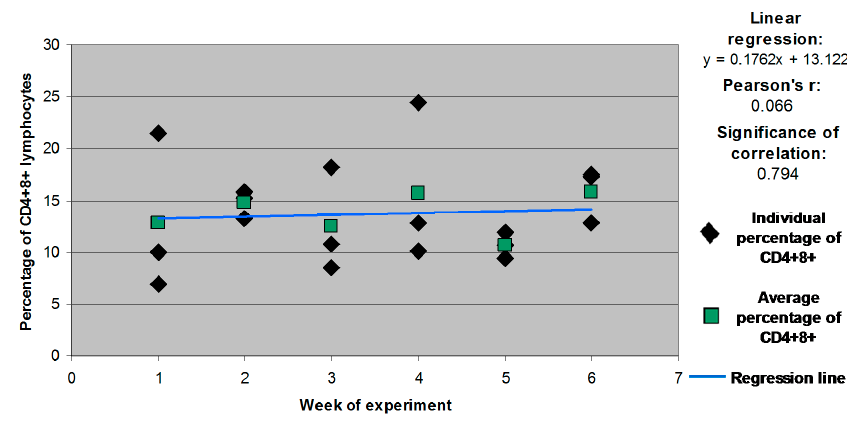
Figure 5. Individual and mean percentages of CD4 + 8 + lymphocyte subpopulations in group E3.